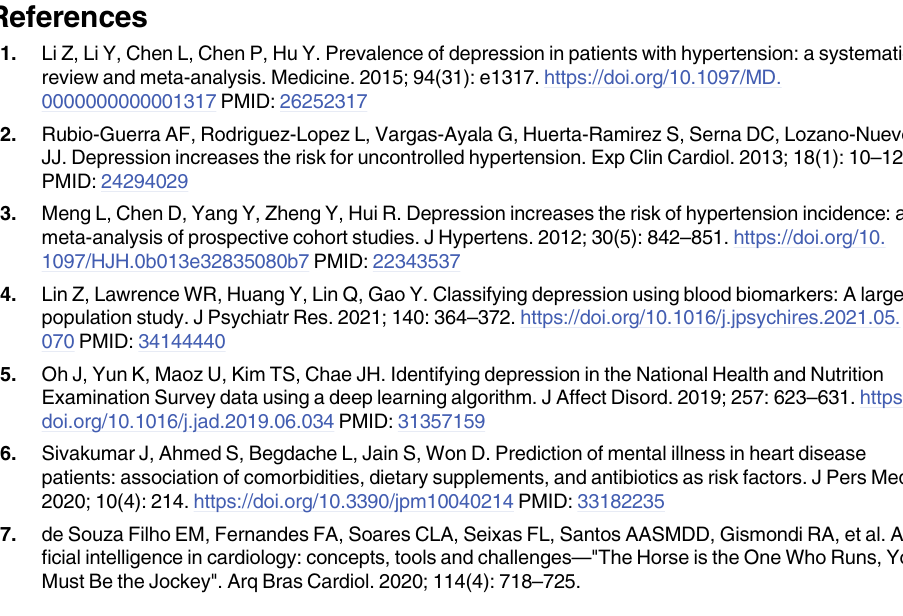
S1 Fig. Feature selection figures (Boruta result plot), diagnostic plot of the Boruta algo- rithm (line plot of Z-scores), and cross-validated deviance with the number of non-zero coefficients and Lambda fit by LASSO logistic regression. S1 Table. The 2 X 2 contingency table. S2 Table. The list of variables selected from the Boruta and LASSO algorithms and step- wise backward elimination. S3 Table. Average metrics of six models trained with Boruta and LASSO algorithms. S4 Table.